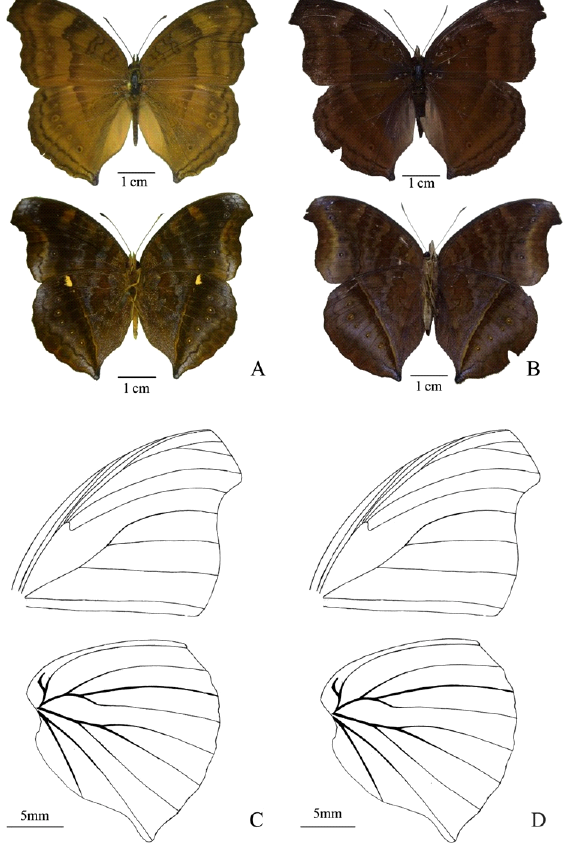
Figure 4. Junonia iphita (Cramer, 1779) A - male (wet season form); B - female (dry season form); C - wing venation (male); D - wing venation